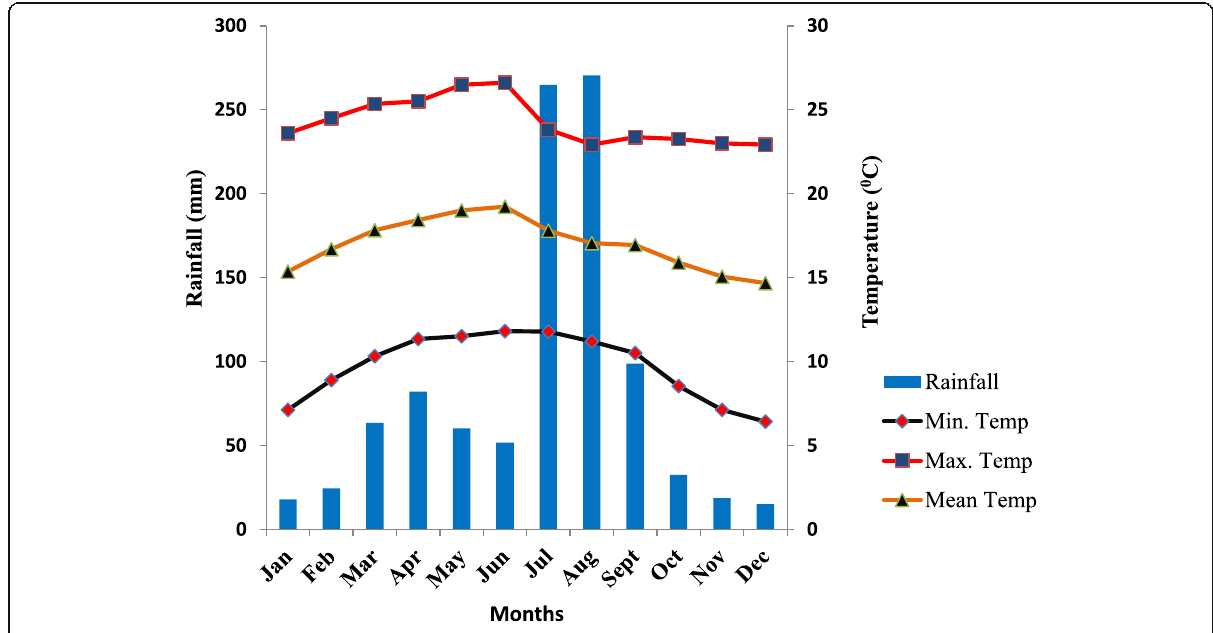
Fig. 4 Monthly average rainfall, maximum, minimum, and mean temperature of South Wollo administrative